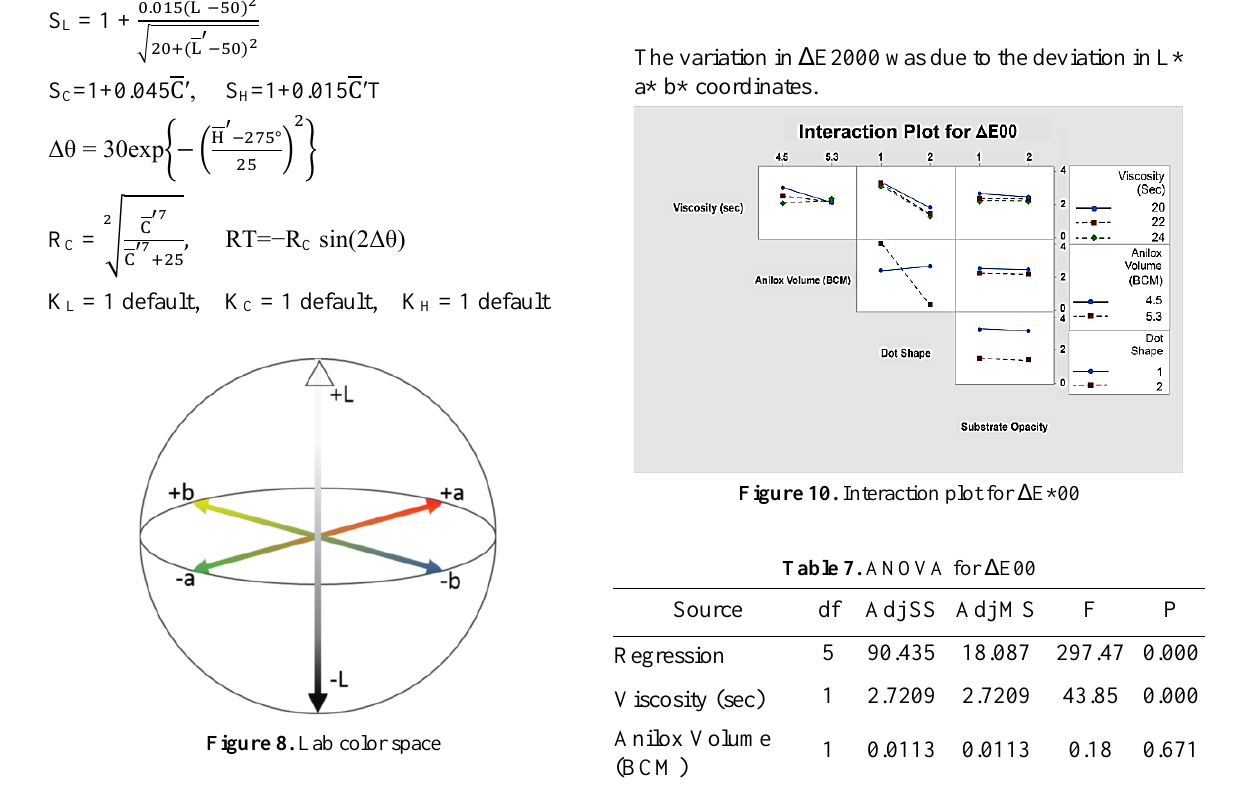
Figure 8. Lab color space